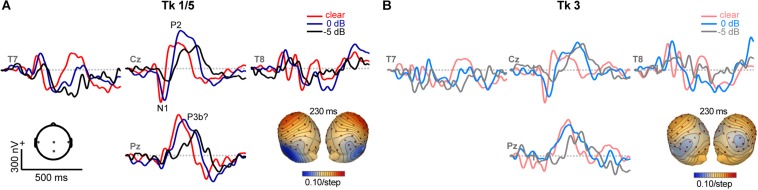
ERPs as a function of speech token and noise (SNR). Representative electrodes at central (Cz), temporal (T7/8) and parietal (Pz) scalp sites. Stimulus and noise-related modulations are most prominent at P2 and following (180–320 ms). (A) Phonetic speech tokens (Tk1, Tk5) elicit stronger ERPs than (B) ambiguous sounds without a clear category (Tk3). Noise weakens and prolongs the neural encoding of speech. Inserts show topographic maps at 230 ms. Hot/cool colors = positive/negative voltage.